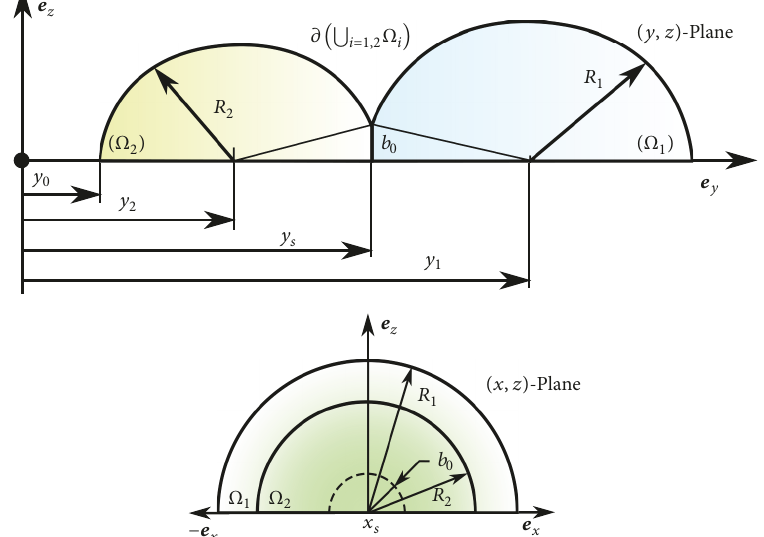
Figure 2: The projection of the coalescence domain in the (𝑦, 𝑧) -plane (top) and in the (𝑥,𝑧) -plane